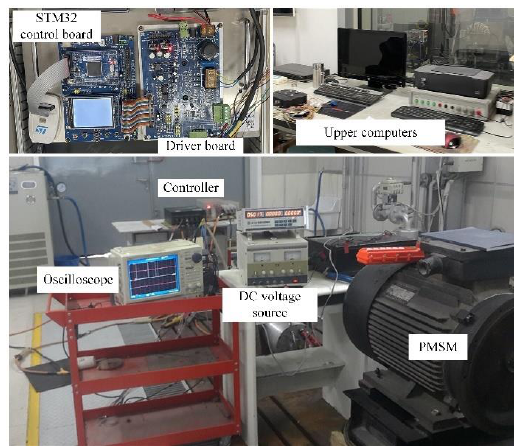
Figure 20. The experimental platform.